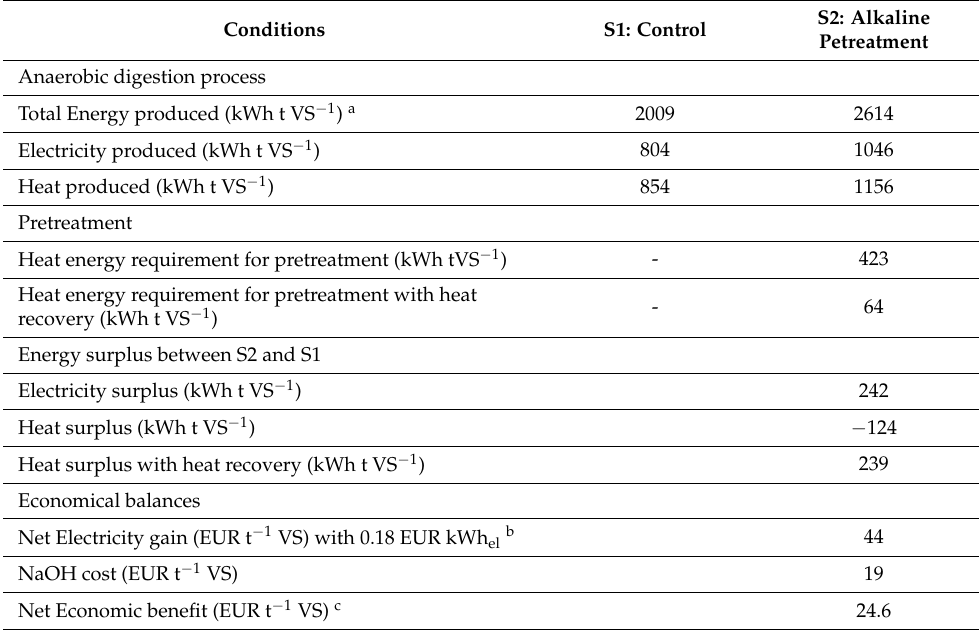
Table 2. Energy and economical balances between Scenario S1 (control WS) and S2 (alkaline- pretreated